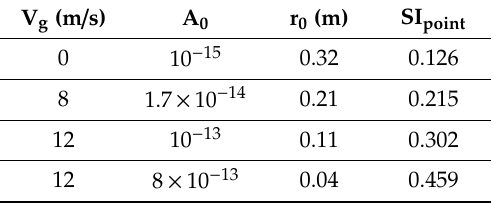
Table 4. Fried parameter and scintillation index values for di ff erent C 2 n ( h )